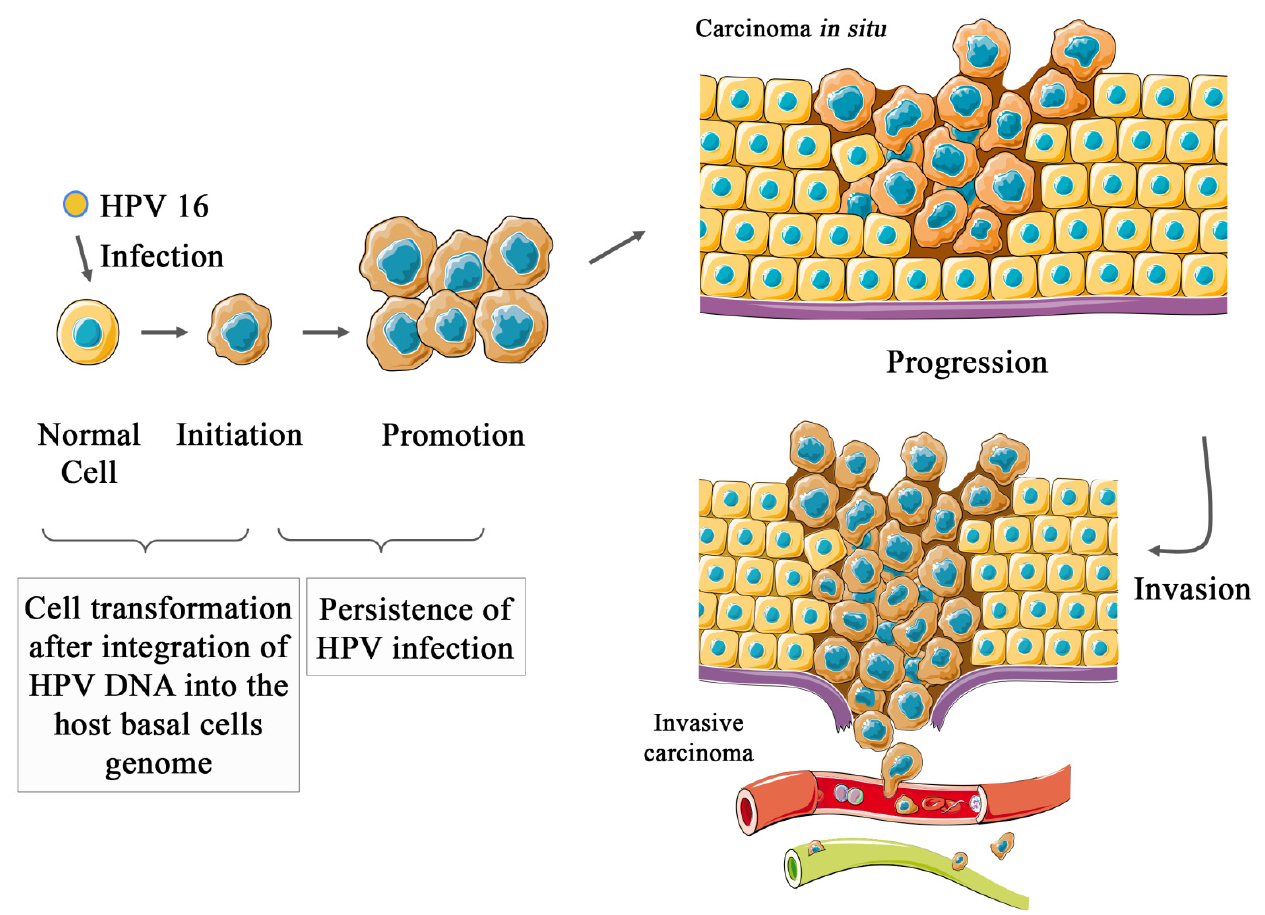
Figure 1. HPV carcinogenesis. This figure shows the general mechanisms of HPV carcinogenesis. After HPV infection, especially the high-risk types (e.g., HPV16), the oncogenes of the HPV can integrate into the host basal cell genome, if the infection is recurrent. If this step happens, it is possible to observe the initiation of the tumor, which can progress to the promotion stage, in which many cells transform to cancer cells. After this, the progression of the cancer cells takes place, and the carcinoma develops in situ and can progress to the invasion step, in which the cancer cells migrate to other tissues, leading to metastasis. Parts of the figure were drawn using pictures from Servier Medical Art. Servier Medical Art by Servier is licensed under a Creative Commons Attribution 3.0 Unported License (https://creativecommons.org/licenses/by/3.0/ accessed on 15 April